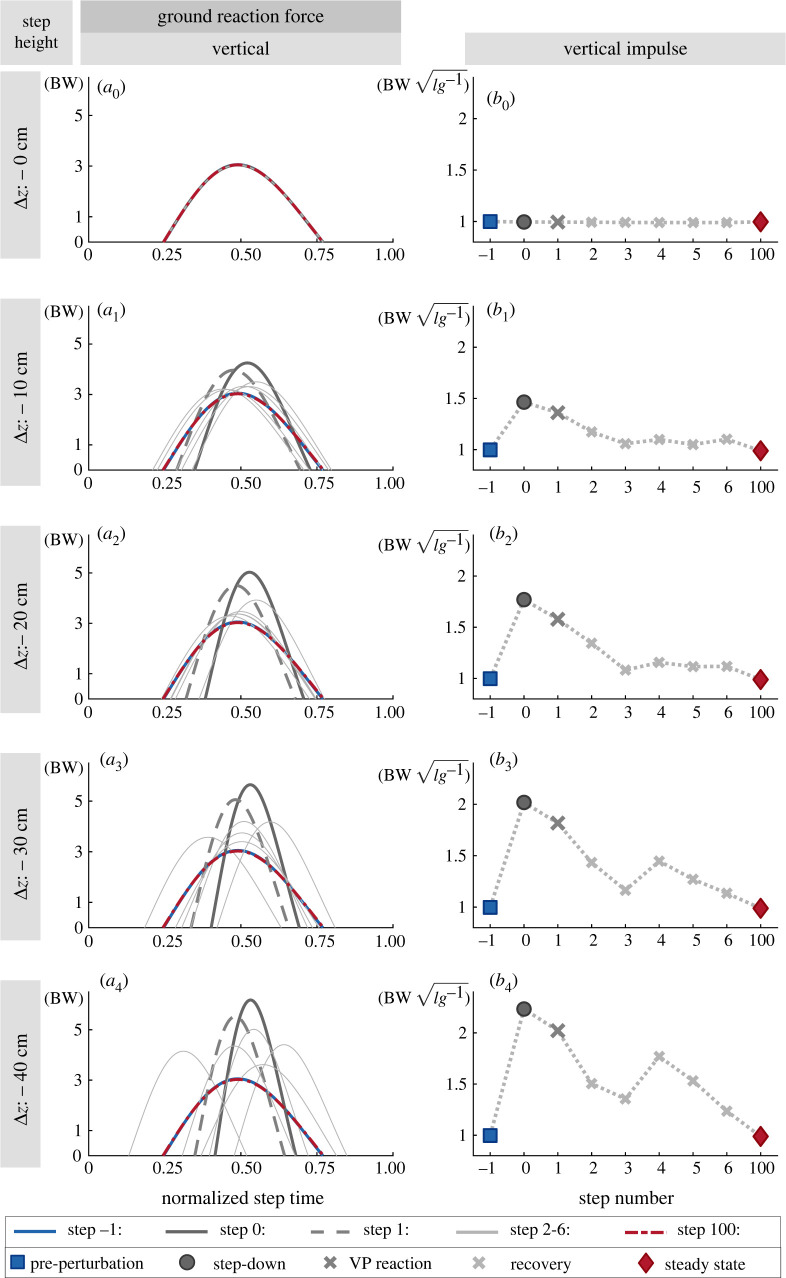
The vertical ground reaction forces over normalized step time are shown (a0−a4). The peak vertical GRF increases with the step-down perturbation. During the following steps, the impulse decreases to its initial value through the regulation of the VP position. The increase in the peak GRF after step-down is proportional to the step-down height. Between steps 4 and 5, the peak vertical GRF increases 1.4 fold for −10 cm drop and twofold for −40 cm drop. In accordance, the vertical impulse increases with the step-down perturbation and returns to its initial value (b0−b4). As the step-down height increases from −10 to −40 cm the vertical impulse increases 1.53-fold from its initial value for step 0 (circle) and 1.48 fold for step 1 (dark cross markers).